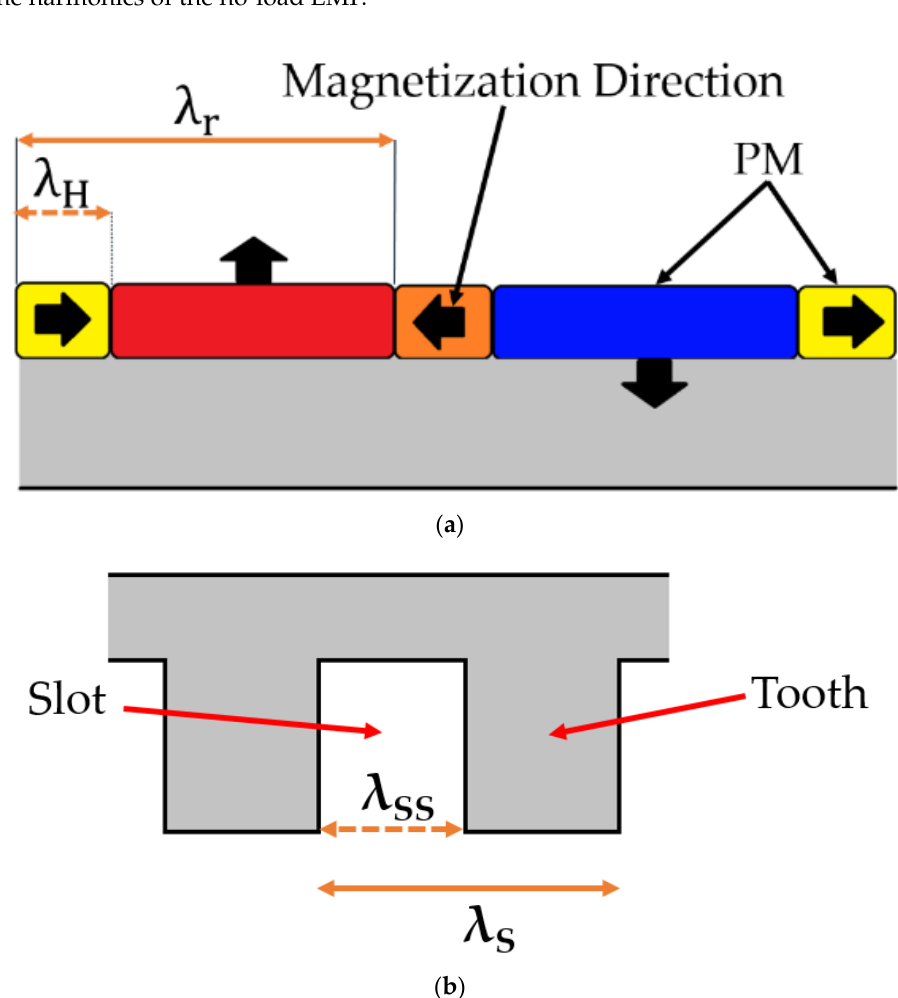
Figure 8. Definition of the two variables studied: ( a ) the ratio 𝜆 (cid:3046)(cid:3046) / 𝜆 (cid:3046) ; (b) the ratio 𝜆 (cid:3009) / 𝜆 (cid:3045) .